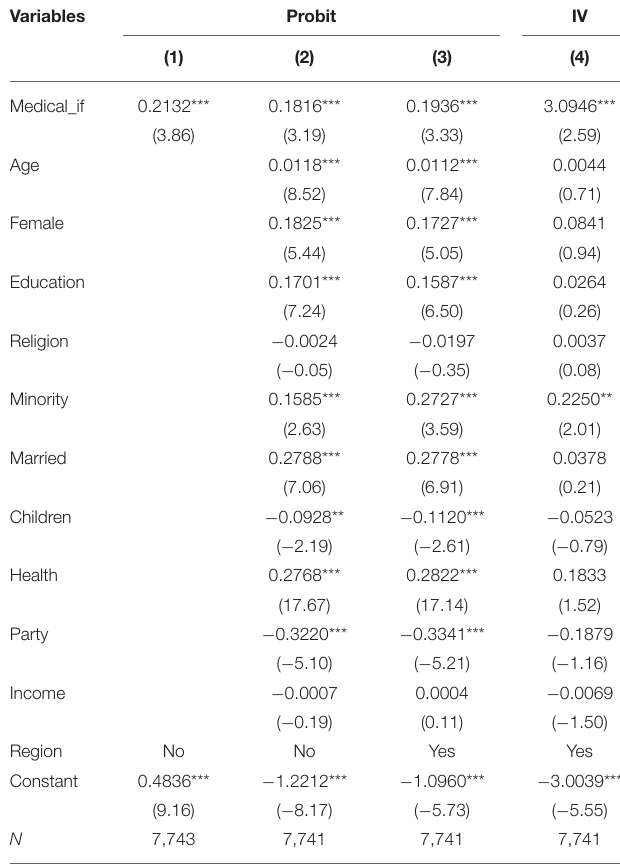
TABLE 2 | Benchmark and IV regression